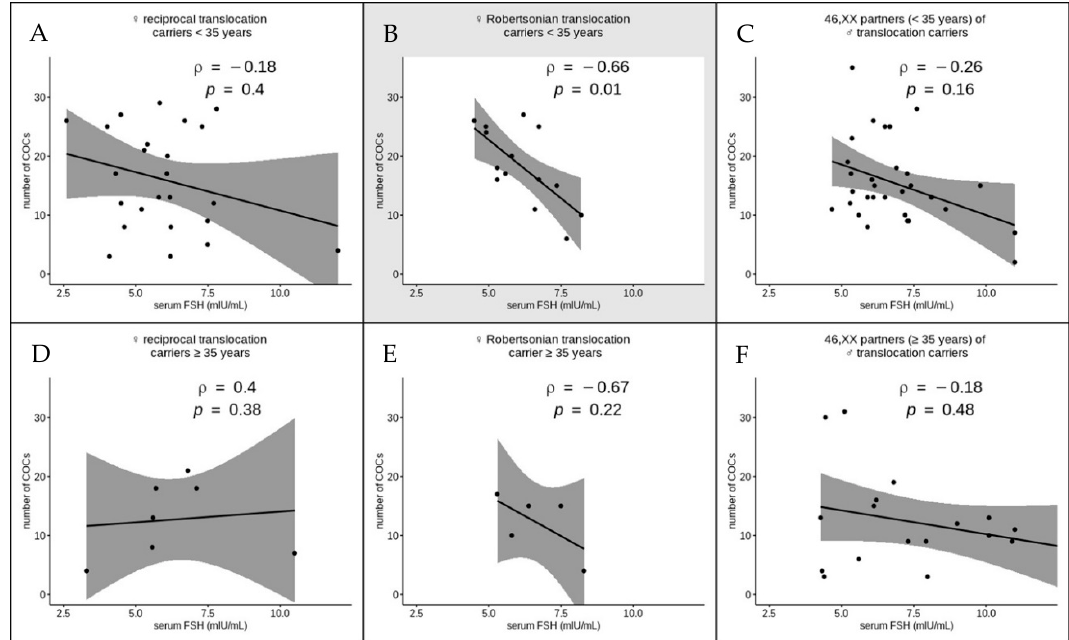
Figure 5. The correlations between the serum follicle-stimulating hormone (FSH) levels and the number of cumulus–oocyte complexes (COCs) retrieved after controlled ovarian hyperstimulation in six subgroups of women subcategorized by age (<35 ( A – C ) and ≥ 35 ( D – F ) years) and presence of a chromosomal rearrangement (female carriers of a reciprocal translocation ( A , D ), female carriers of a Robertsonian translocation ( B , E ) and karyotypically normal partners of male translocation carriers ( C , F )). The statistically significant correlations are shaded in gray ( p < 0.05, Spearman test).